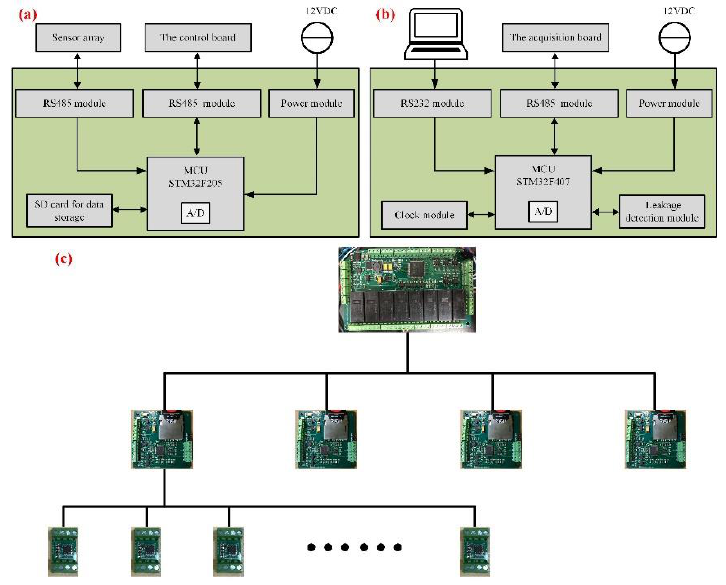
Figure 5. ( a ) “The acquisition board”; ( b ) “The control board”; ( c ) Control system structure.